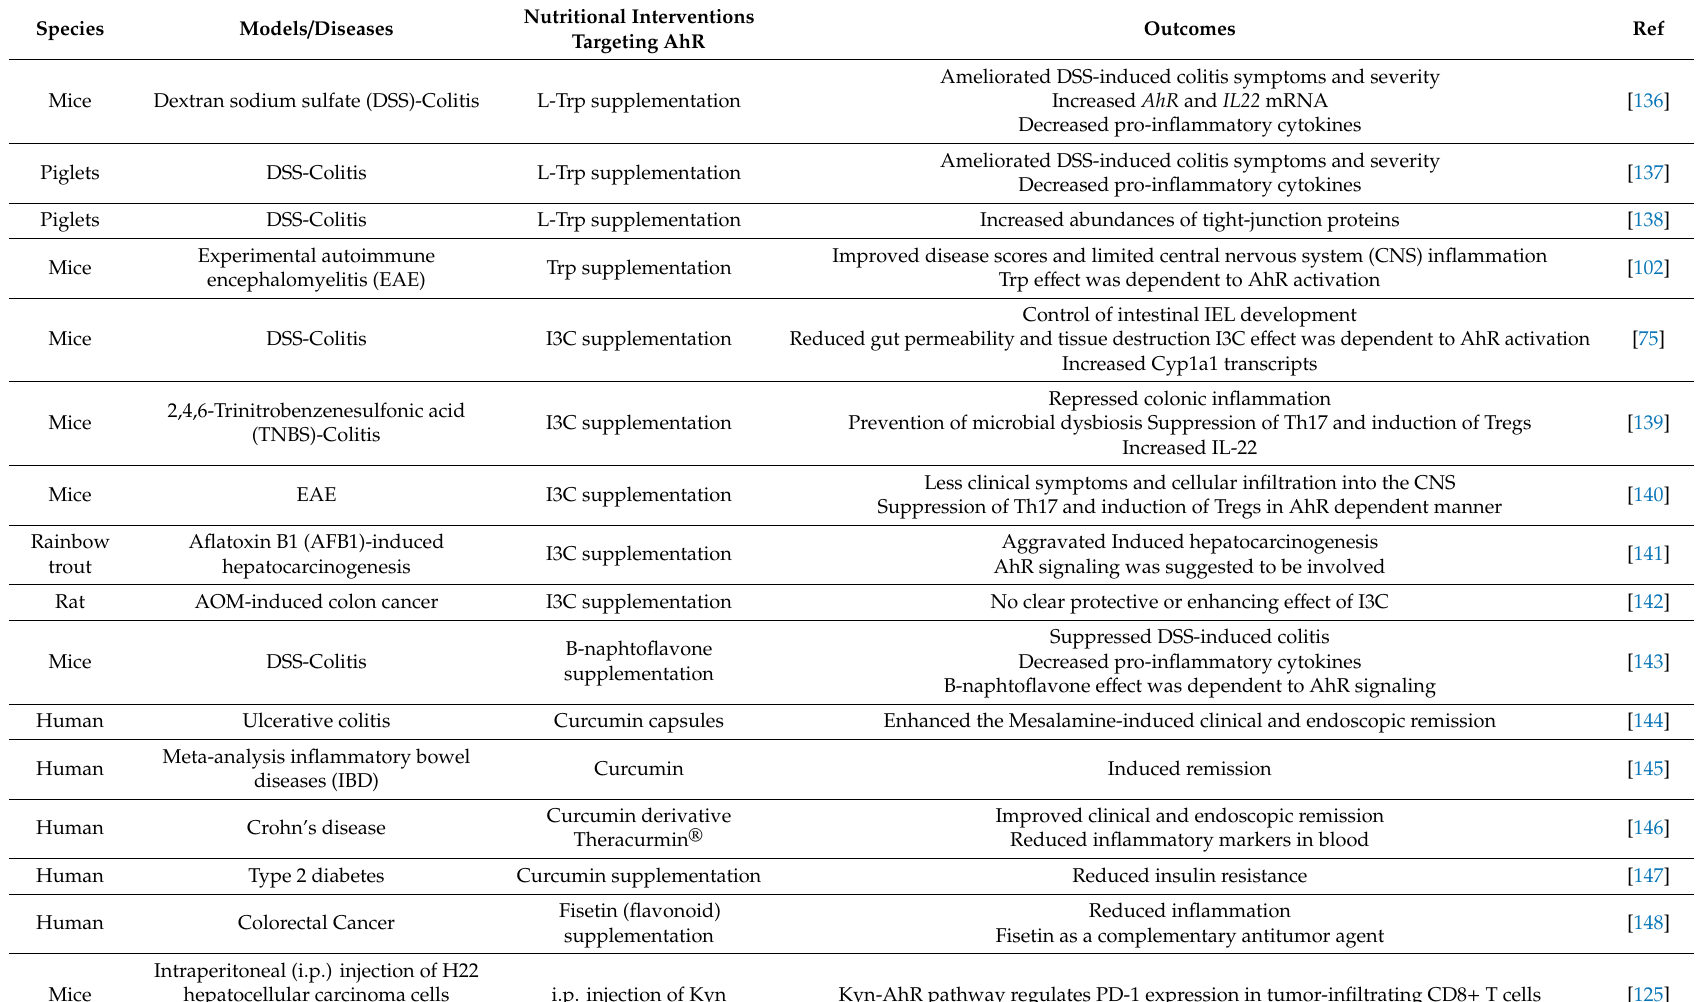
Table 1. Summary of some of the main nutritional interventions targeting AhR studies in animal models and human